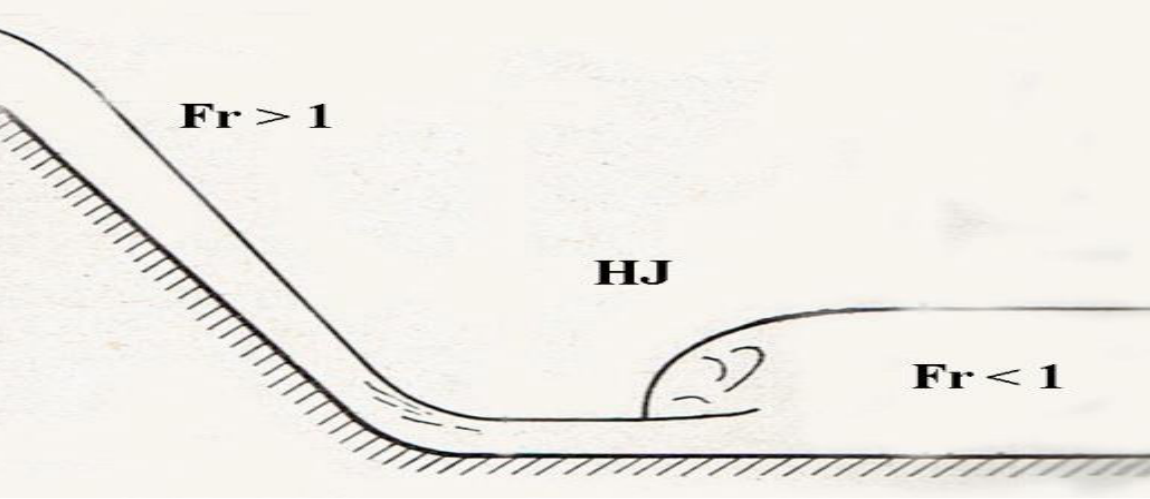
Figure 18. Schematic representation of the formation of a hydraulic jump (HJ) due to the aqueduct slope change from a steep to a mild near-horizontal slope.